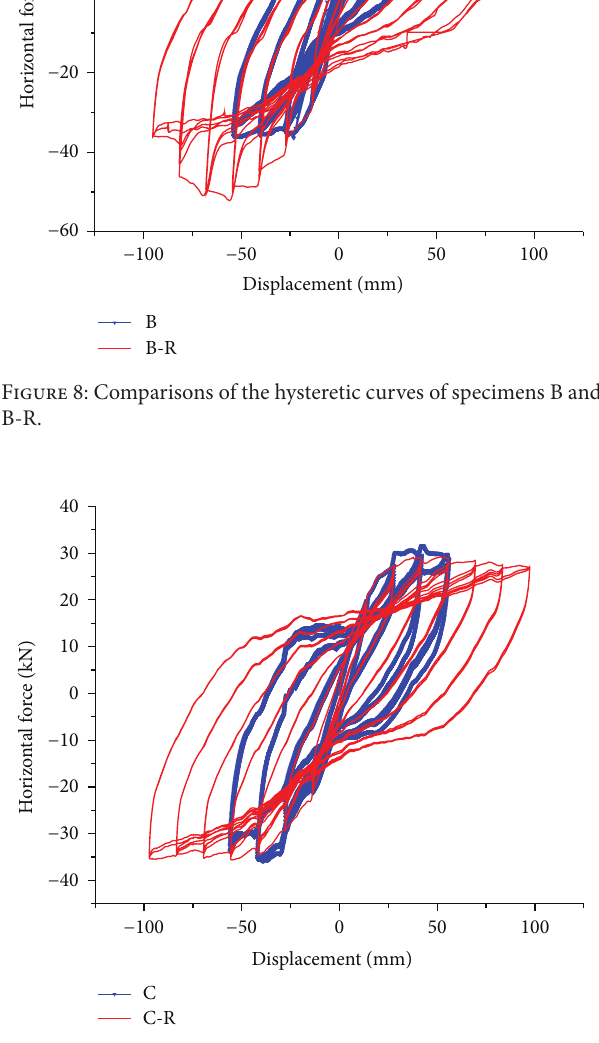
Figure 9: Comparisons of the hysteretic curves of specimens C and